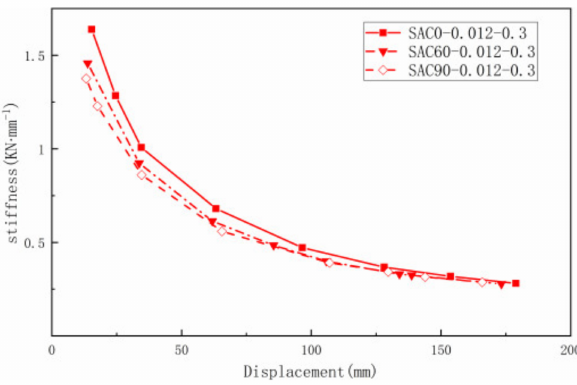
Figure 10. Relationship between stiffness degradation and